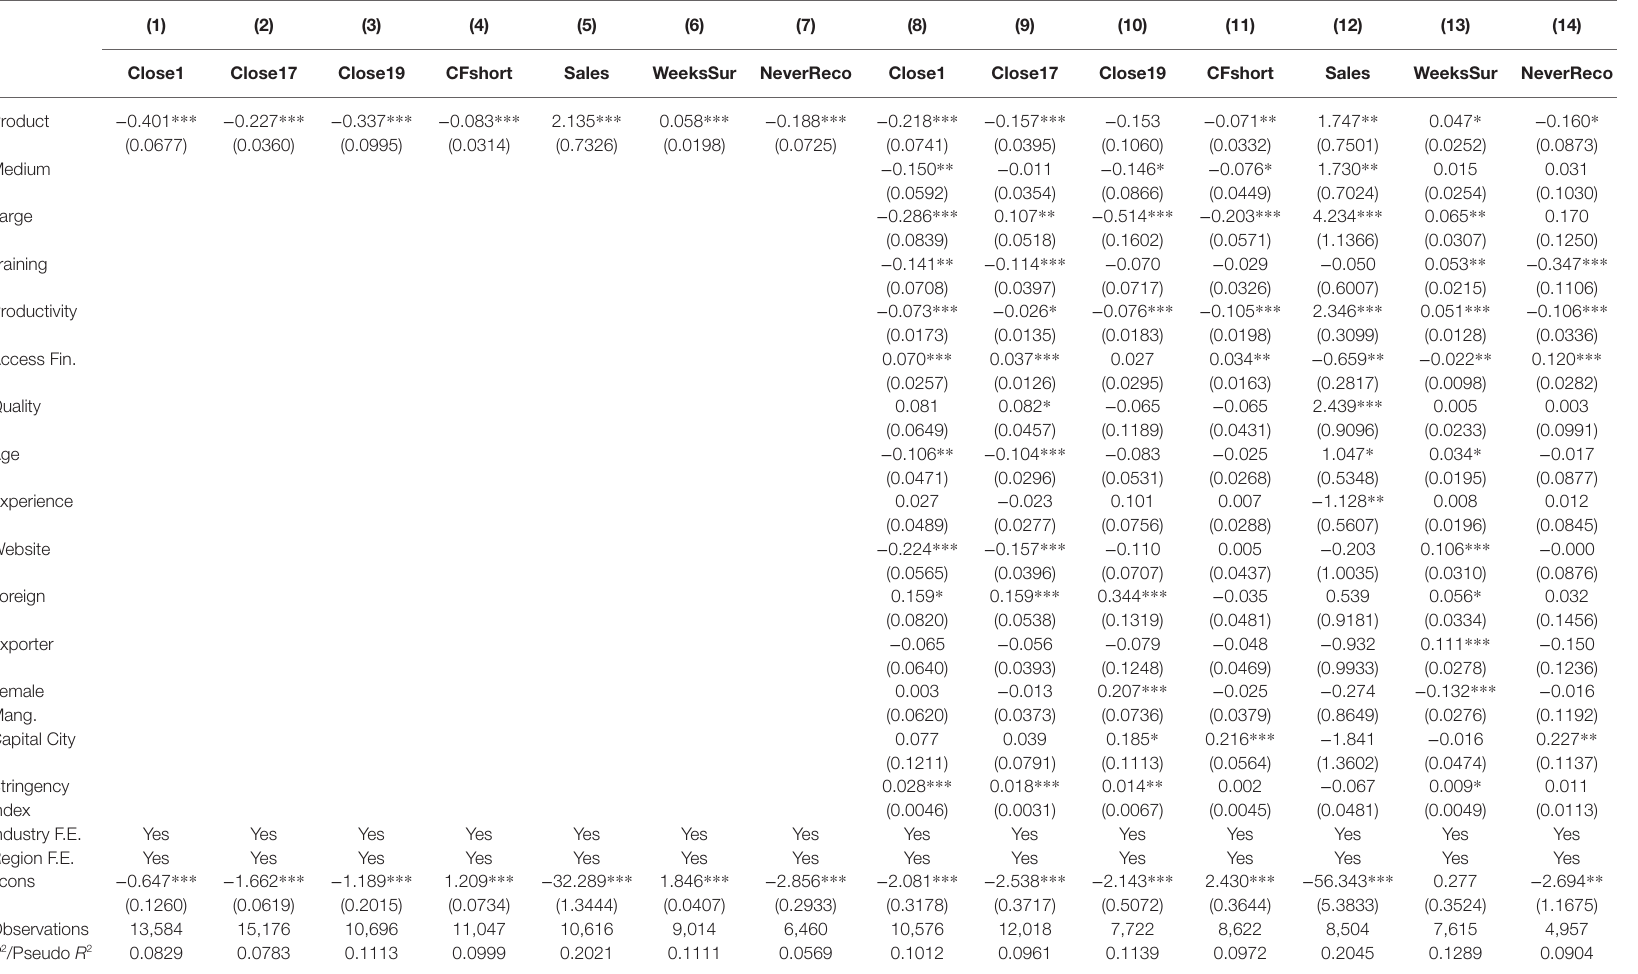
TABLE 2 | Product innovation, closure, performance, and